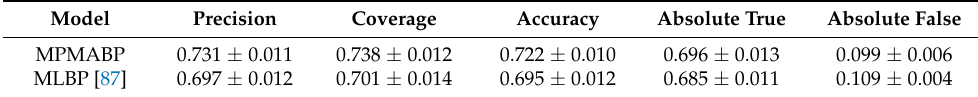
Table 2. The 5-fold cross-validation results of the training dataset. Model Precision Coverage